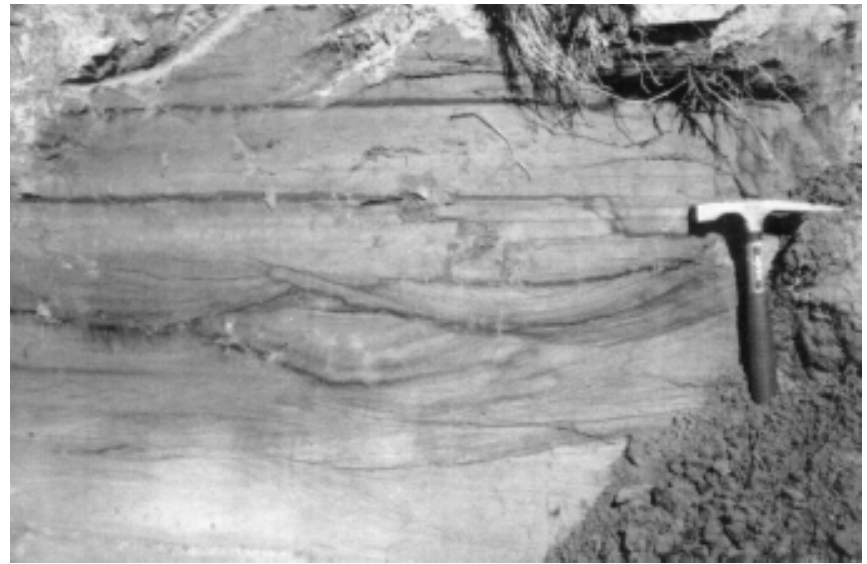
Fig. 3 – The primary hydrodynamic sedimentary structures, like parallel horizontal and through cross-beddings, observed in a shallow marine sand of Pleistocene age, near Paulo Lopes.